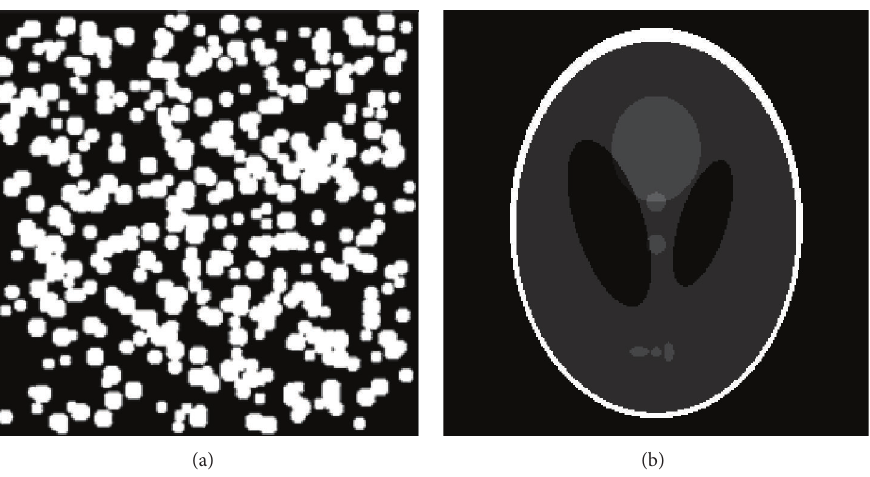
Figure 5: Two phantom images. (a) Stacked particles phantom. (b) Shepp-Logan head phantom.